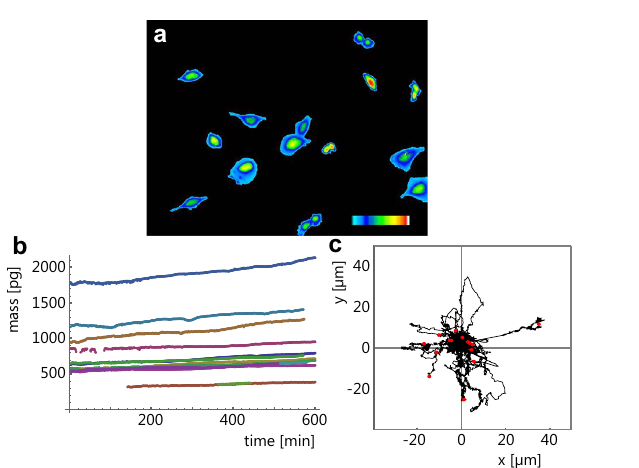
Figure 2. Images from a time-lapse sequence recording red and green fluorescence of pneumocytes type II and human non-small cell lung carcinoma A549 cells, respectively. ( a ) pneumocytes labeled red at time point 0 min; ( b ) A549 cells labeled green at time point 0 min; ( c ) overlay at time point 0 min; ( d ) pneumocytes labeled red at time point 210 min; ( e ) A549 cells labeled green at time point 210 min; ( f ) overlay at time point 210 min. The yellow arrow at the same position in each image points to an invasion even. The green A549 cell migrated towards the arrow first and subsequently invaded the confluent pneumocyte monolayer opening a hole. This created a black gap between the red pneumocyte cells, which were originally in close contact. We know from confocal microscopy that the invading cells attach to the substrate when displacing the pneumocytes. The presented field size is 434 × 434 µm.